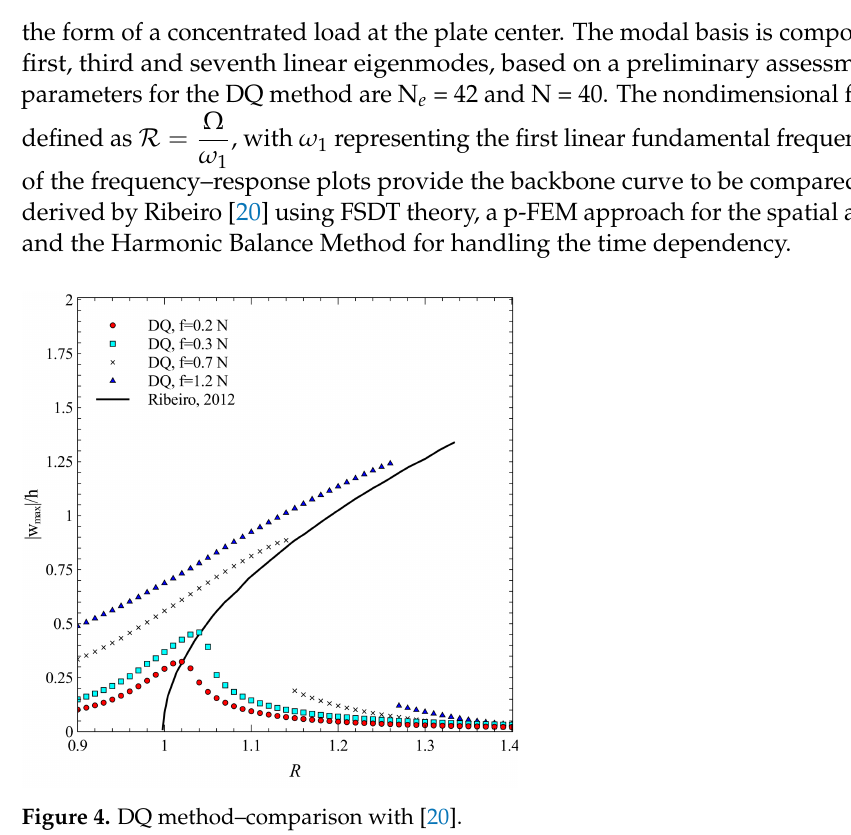
Figure 4. DQ method–comparison with